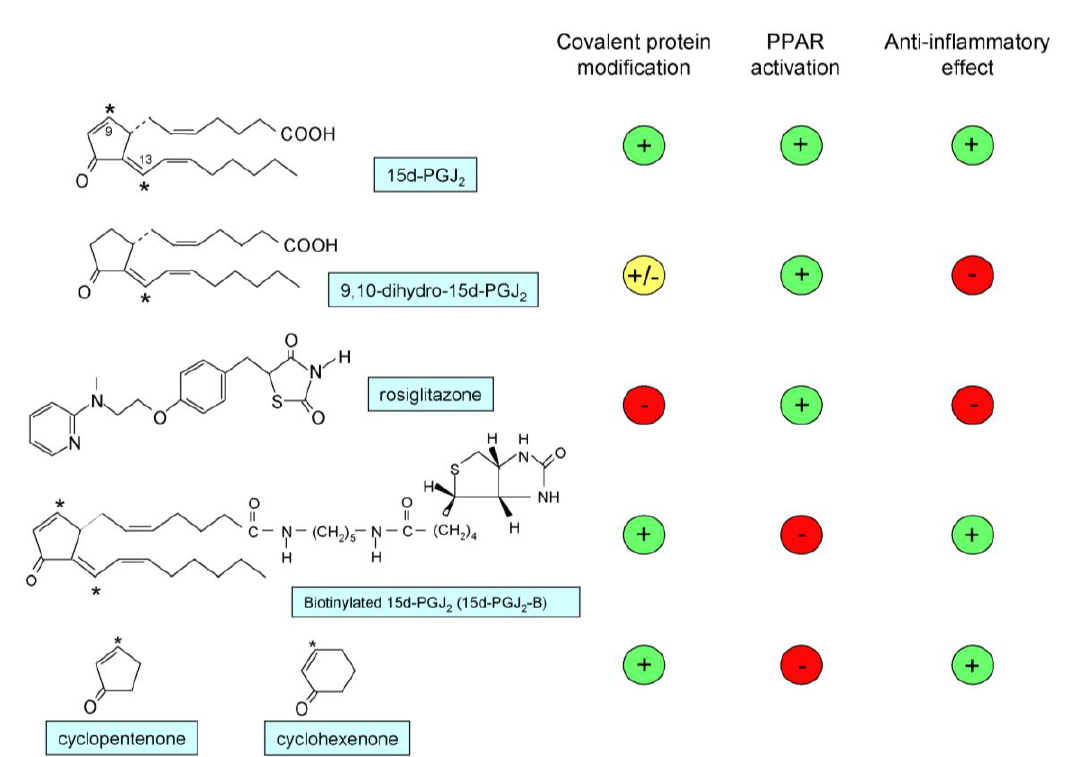
FIGURE 3. Contribution of covalent protein modification to the anti-inflammatory effects of cyPG in mesangial cells. A summary of the results obtained in rat mesangial cells through the use of various compounds differing in their ability to activate PPAR and to modify proteins covalently is shown along with their structure. 15d-PGJ 2 efficiently activates PPAR, binds covalently to proteins, and elicits anti-inflammatory actions. The analog of 15d-PGJ 2 , 9,10-dihydro-15d-PGJ 2 , which lacks the endocyclic double bond, but is a potent PPAR  agonist, shows greatly reduced ability to inhibit the induction of COX-2 or iNOS by cytokines in cellular models. The same applies to rosiglitazone, which is a potent PPAR  agonist, but does not bind covalently to proteins and does not display anti-inflammatory actions in this system. In contrast, simple cyclic compounds with  ,  -unsaturated carbonyls, such as cyclopentenone and cyclohexenone, which are inert as PPAR agonists, display anti- inflammatory effects. Biotinylated cyPG bind covalently to proteins and mimic many of the effects of their parent PG in spite of the presence of the bulky biotin moiety, including disruption of the vimentin cytoskeleton, inhibition of iNOS induction by cytokines or induction of permeability transition in mitochondria. Interestingly, biotinylated cyPG appear to be inert as PPAR agonists. Taken together, these observations highlight the importance of covalent protein modification over PPAR activation for the anti-inflammatory effects of cyPG in mesangial